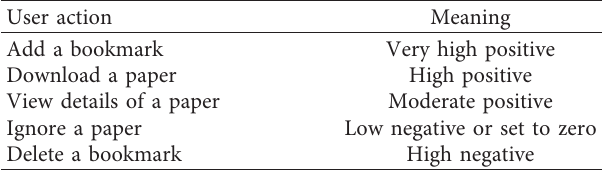
Table 1: Meaning of user